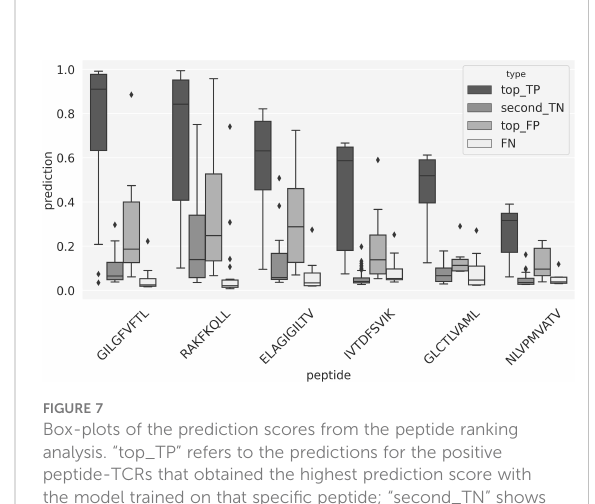
FIGURE 7 Box-plots of the prediction scores from the peptide ranking analysis. “ top_TP ” refers to the predictions for the positive peptide-TCRs that obtained the highest prediction score with the model trained on that speci fi c peptide; “ second_TN ” shows the predictions for the second highest scoring TCR. “ top_FP ” and “ FN ” refer to a scenario where a TCRs gets the highest prediction score when paired to a peptide that is different from its target. “ top_false_FN ” shows the score distribution of these wrong combinations of peptide and TCR; “ FN ” represents the prediction score of the correct peptide-TCR pairs that did not score top